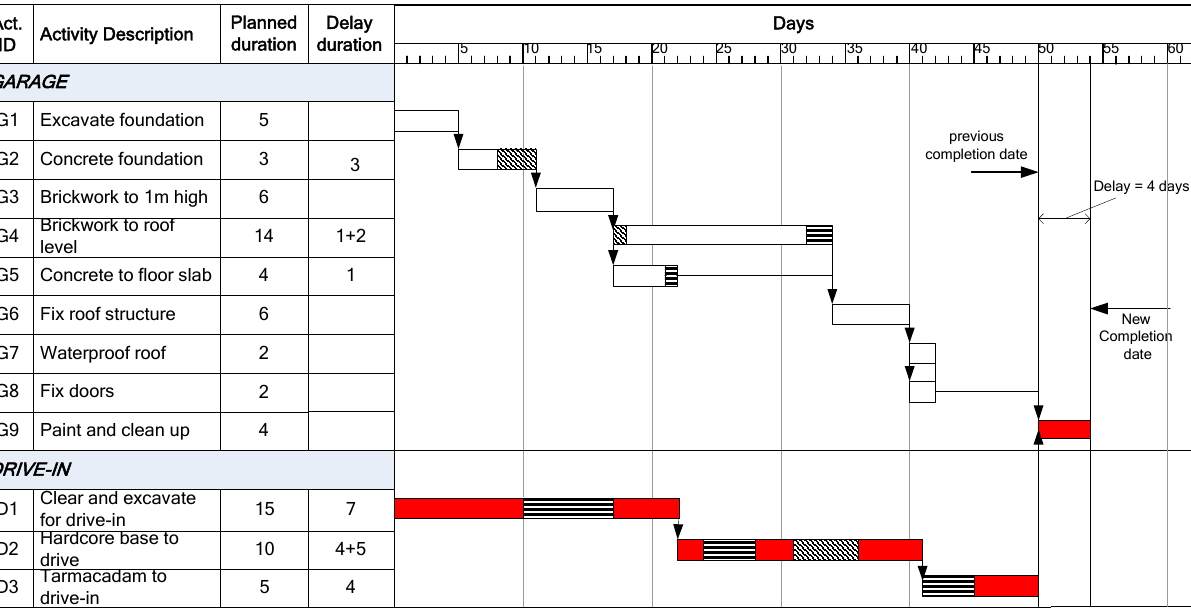
Figure 12. Impact of eighth